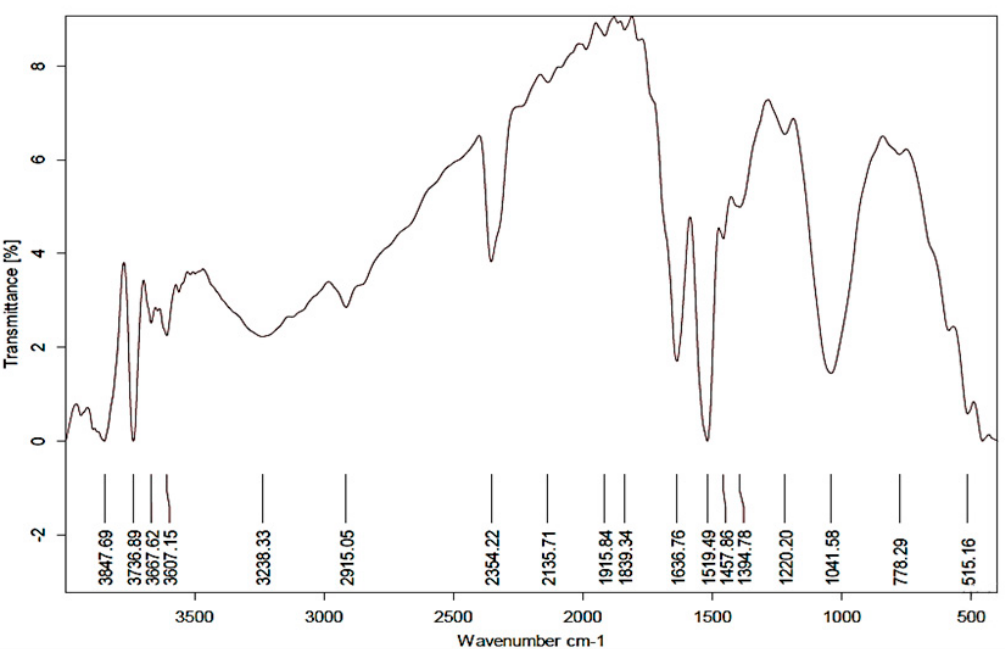
Figure 4. The Fourier transform infrared (FTIR) spectra of biosynthesized Ag-NPs using Ocimum basilicum leaf extract as reducing agent.